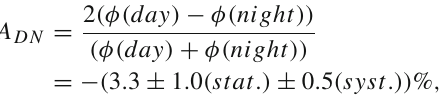
Fig. 13 Allowed parameter regions from the fits in the plane of sin 2 θ 12 and Δ m 2 . The green area shows the result from the solar global anal- 12 ysis and the blue one shows the KamLAND (long baseline reactor anti-neutrino oscillation experiment) results. The red colored region is obtained by combined all solar and KamLAND experiments. There is a ∼ 2 σ difference between the two best fit values